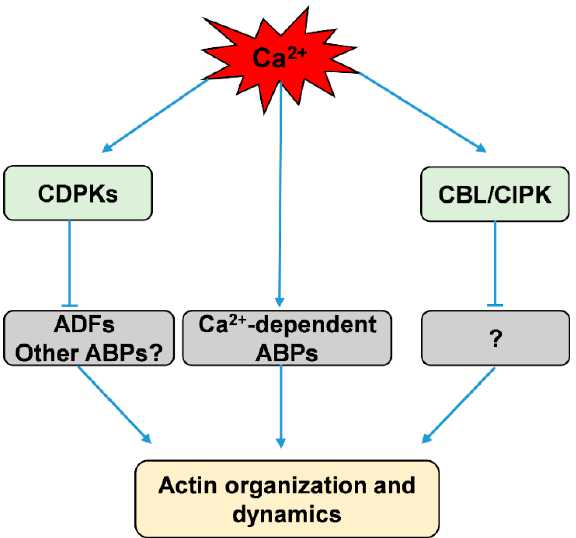
Figure 1. Simplified scheme showing calcium regulation of actin dynamics via direct and indirect pathways. CDPKs, calcium-dependent protein kinases; CBL/CIPK, calcineurin B-like protein and CBL-interacting protein kinases; ADFs, actin-depolymerizing factors; ABPs, actin-binding proteins.